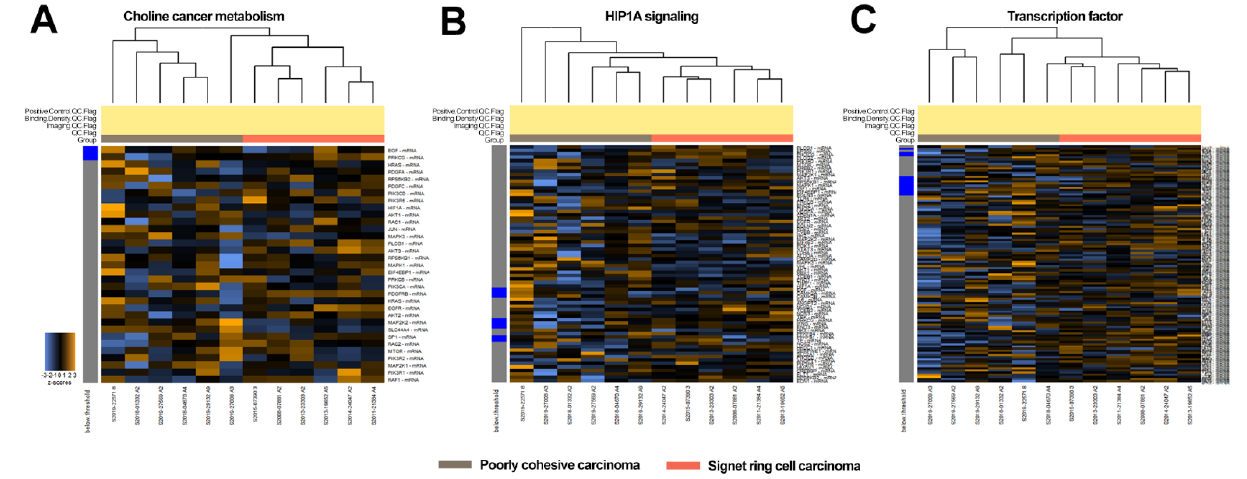
Figure 2. Expression of cancer progression-related genes in signet ring cell carcinoma and poorly cohesive carcinoma. Genes related to ( A ) choline cancer metabolism, ( B ) HIP1A signaling, and ( C ) transcription factor.